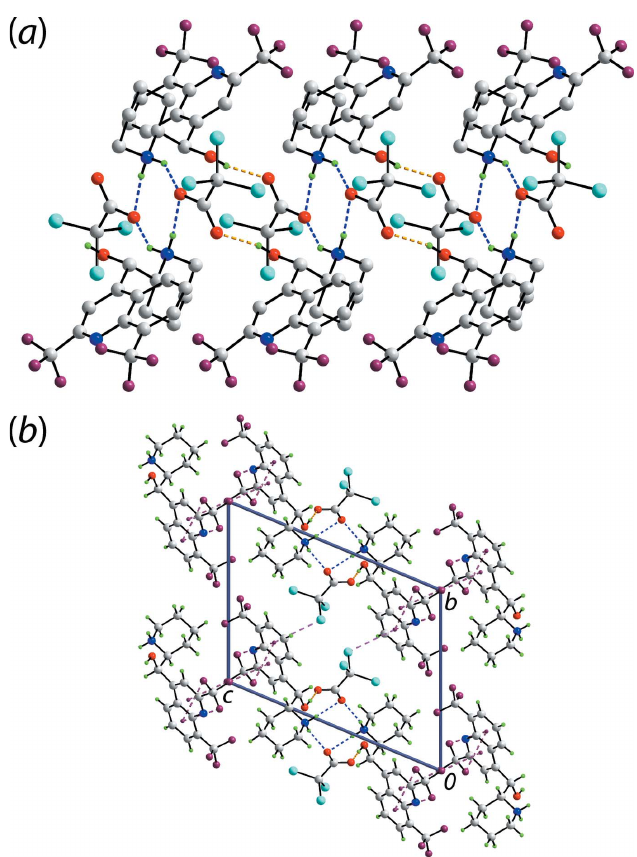
Figure 2 Molecular packing in (I): ( a ) The supramolecular chain along the a axis, being sustained by O—H (cid:2)(cid:2)(cid:2) O and N—H (cid:2)(cid:2)(cid:2) O hydrogen bonding with non-participating H atoms omitted and ( b ) a view of the unit-cell contents shown in projection down the a axis, the axis of propagation of the chain shown in ( a ). The C—Cl (cid:2)(cid:2)(cid:2) (cid:2) and C—F (cid:2)(cid:2)(cid:2) (cid:2) interactions are shown as pink and purple dashed lines,